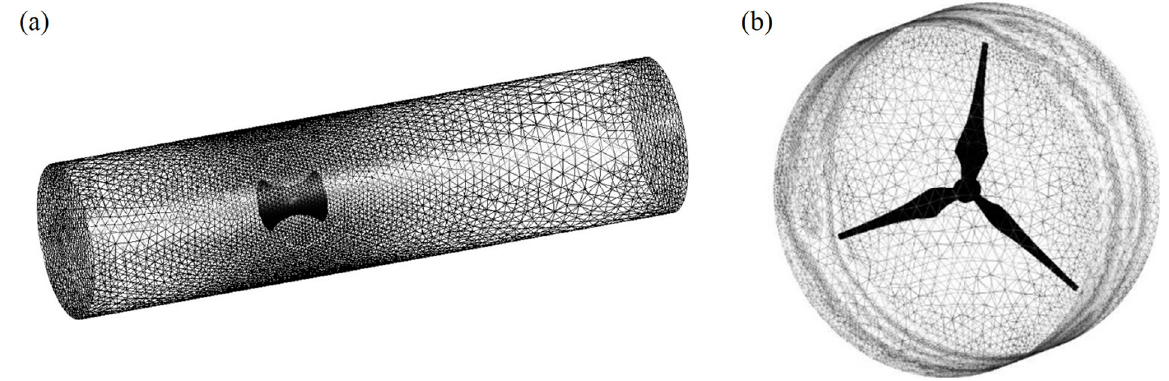
Figure 6. Grid topology and finer mesh around the ( a ) duct and ( b ) turbine blades.